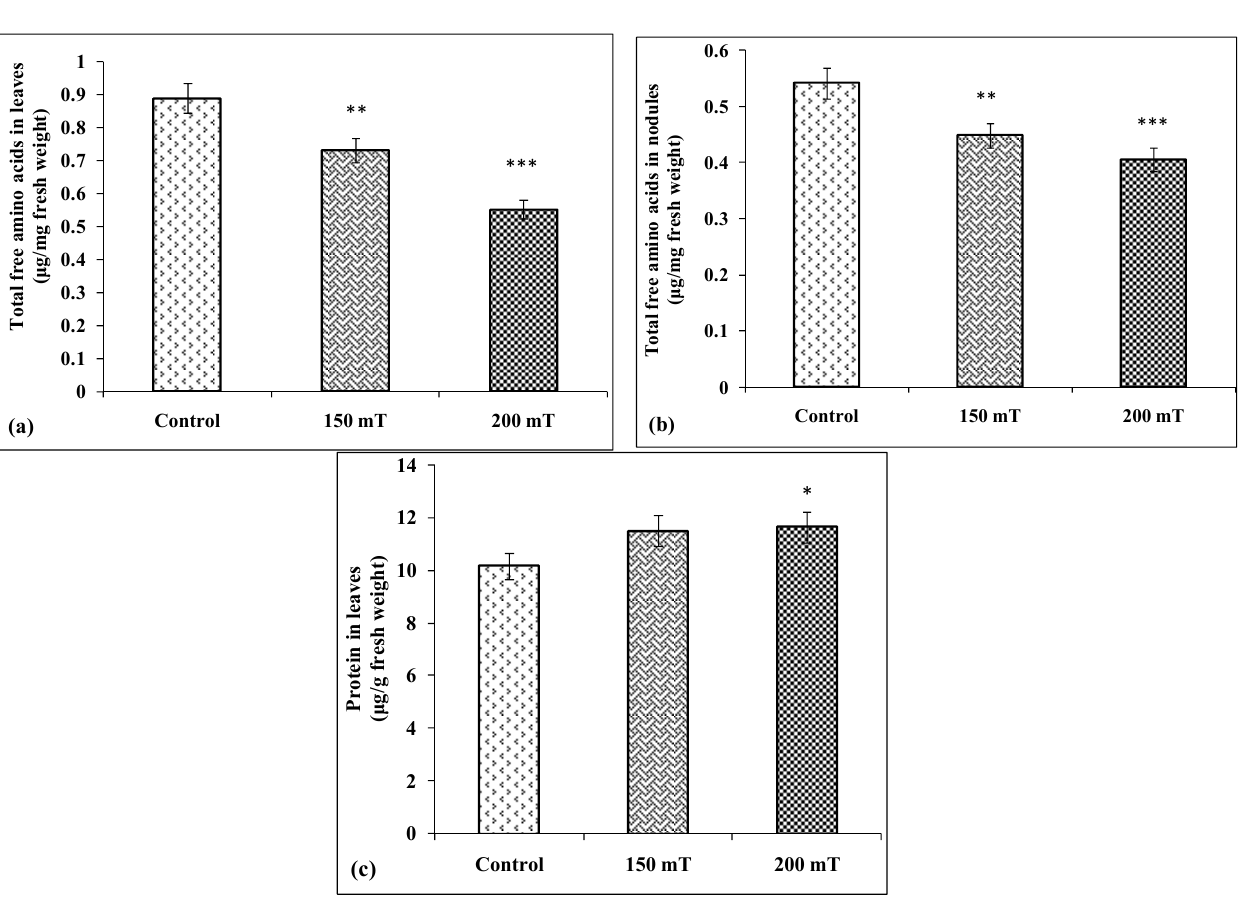
18 Figure 17. Spectral analysis of leghemoglobin isolated from root nodules of soybean plants on 45th DAE, where A stands for absorbance and div for divisions.